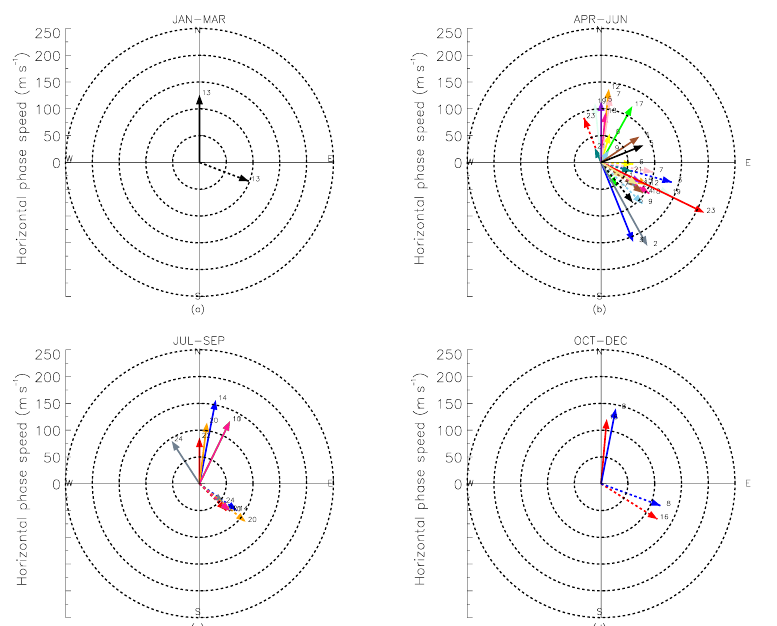
Figure 5. Vector diagrams for the winds (dashed arrows) and phase velocity (solid arrows) observed during the summer (a) , autumn (b) , winter (c) and spring (d) .